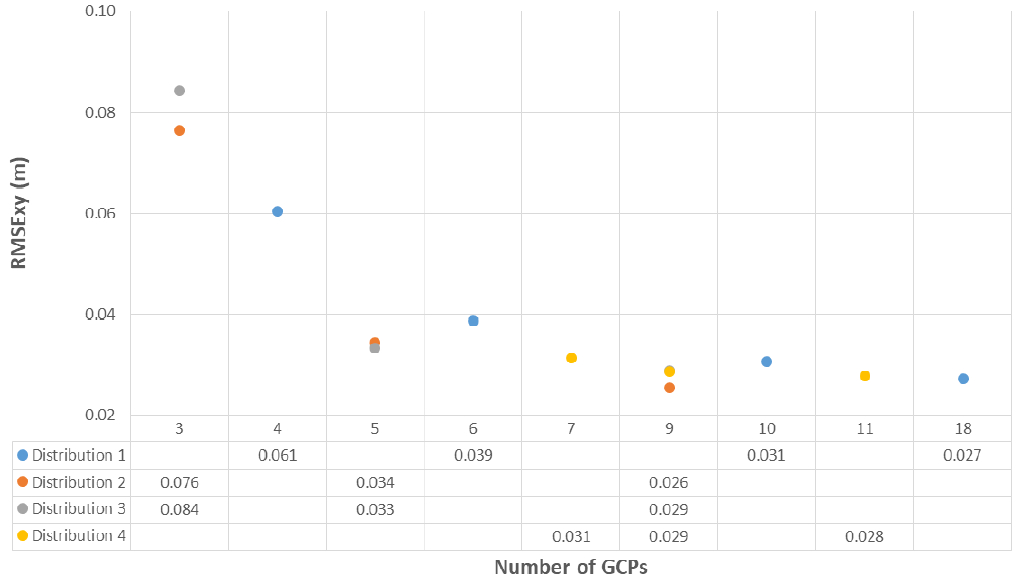
Figure 9. RMSExy values (in meters) obtained according to the number of GCPs used in the bundle adjustment. Each distribution is represented by a different color.